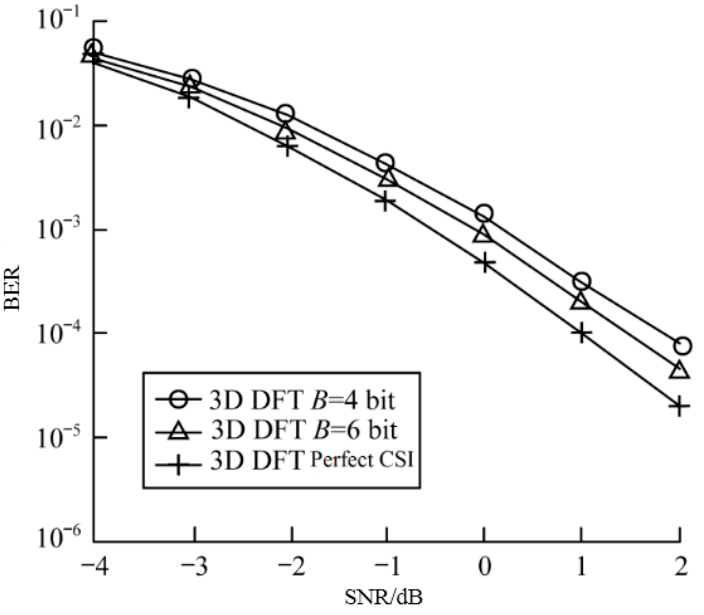
Figure 7. The relationship between the BER and SNR for the proposed 3D DFT Scheme for a different number of feedback bits.